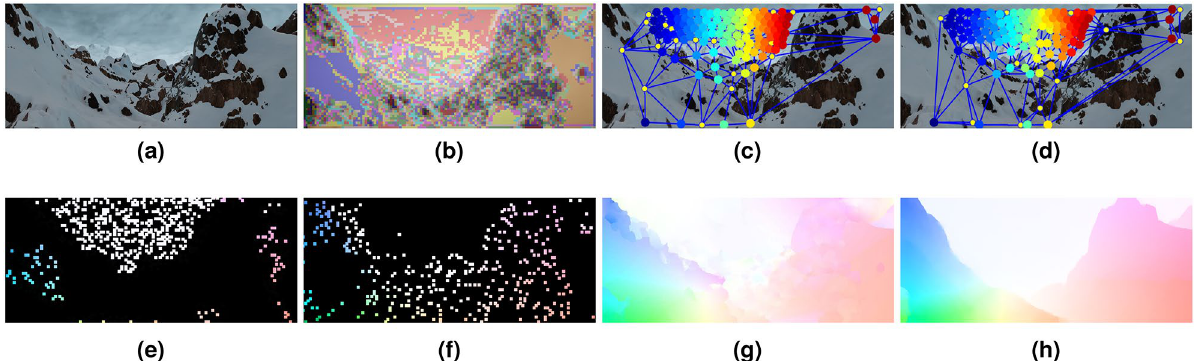
Figure 1. ( a ) Input image frame. ( b ) Coarse-scale clusters from pixels’ feature descriptors. ( c ) Color-coded graph matches of one coarse-scale cluster; first frame ( a ). ( d ) Color-coded graph matches for ( c ); second frame. ( e ) Motion vectors from graph-matching of superpixels at finest-scale. ( f ) Motion vectors from pixel feature matching in small clusters. ( g ) Interpolated flow from the combined initial motion vectors ( e+f ). ( h )